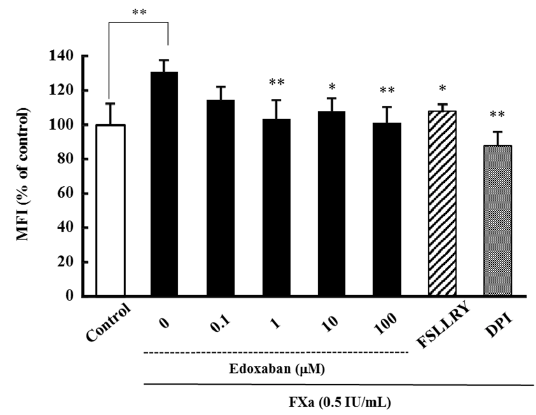
E ff ect of edoxaban-on FXa-derived intracellular reactive oxygen species (ROS) production in human proximal tubular cells (HK-2 cells). E ff ect of edoxaban (0.1–100 µ M), Phe-Ser-Leu-Leu-Arg-Tyr-NH2 (FSLLRY-NH2) (10 µ M) as an inhibitor of protease-activated receptor-2 (PAR-2), and diphenyleneiodonium chloride (DPI) (50 µ M) as an inhibitor of nicotinamide adenine dinucleotide phosphate (NADPH) oxidase on FXa-induced intracellular ROS production in HK-2 cells. Values are expressed as the mean ± S.D. ( n = 4). * p < 0.05, ** p < 0.01 vs. FXa